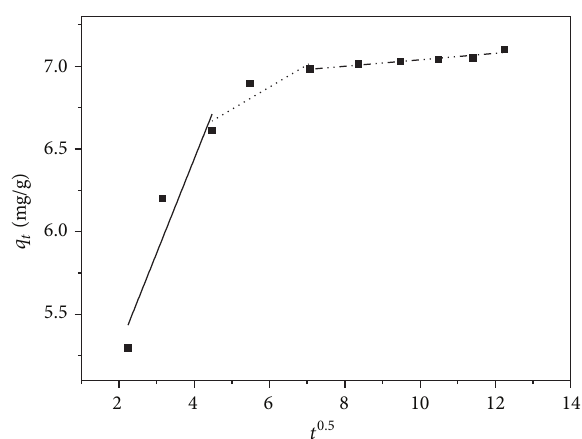
Figure 6: Intraparticle diffusion kinetics for adsorption of Cd(II) onto WAS.